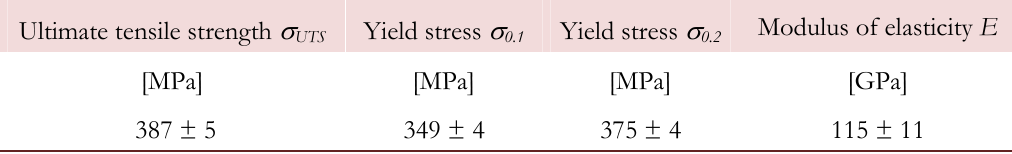
Table 1: Tensile properties of UFG Cu prepared by ECAP, route Bc, 8